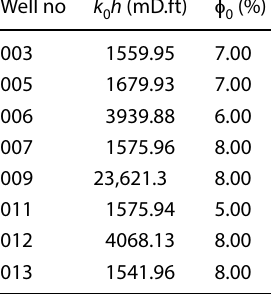
Table 2 Well characteristics at the reservoir unit cross